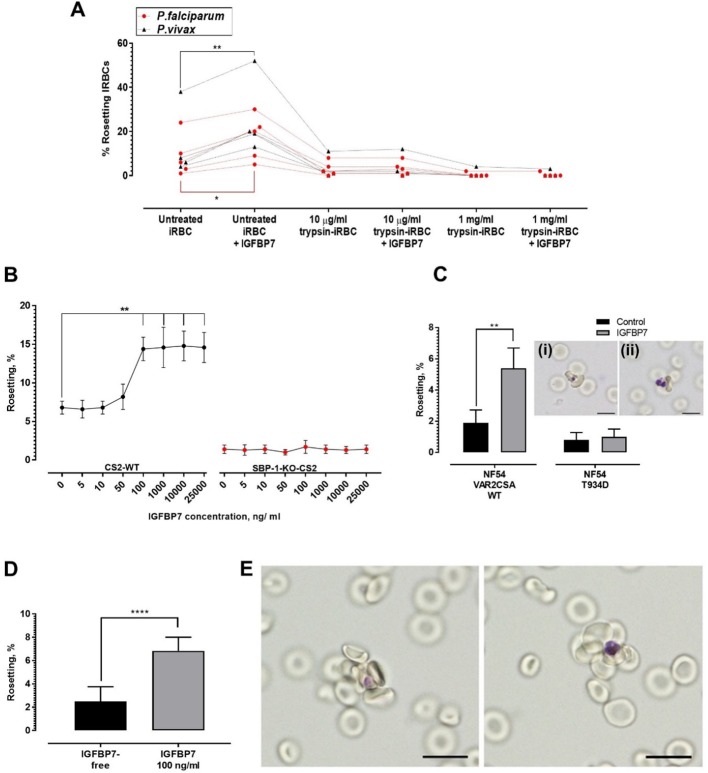
Deciphering rosetting ligands involved in IGFBP7-mediated rosetting.(A) IRBC-trypsin treatments on IGFBP7-mediated rosetting. Dotted lines demonstrate data collected from same isolates. IGFBP7 increased rosetting in the untreated settings (paired t-test Pf (n = 5): p=0.0171; Pv (n = 4): p=0.0023) but did not significantly alter rosetting in groups treated with 10 µg/ml trypsin (Pf: p=0.3739; Pv: p=0.3910) and 1 mg/ml trypsin (Pf: same values; Pv: p=0.3910). (B) Rosetting rates (mean and SD from quintuplicate experiment repeats shown) along rhIGFBP7 concentrations for PfCS2-WT and PfSBP1-KO-CS2. Significant CS2-WT rosette-stimulation was noted from rhIGFBP7 of 100 ng/ml (Friedman with Dunn’s test: p=0.0230). No significant changes noted for SBP1-KO-CS2 across the range of IGFBP7 concentrations studied (Friedman with Dunn’s test: p>0.9999). (C) Effect of IGFBP7 on rosetting rates of NF54_VAR2CSA_WT and NF54_T934D (mean and SD from quintuplicate experiment repeats shown). The Mann-Whitney test was conducted. For NF54_VAR2CSA_WT, IGFBP7 significantly increased the rosetting rates (p=0.0079). For NF54 VAR2CSAT934D, IGFBP7 did not cause any significant change to the rosetting rates of the parasite (p=0.7619). The rosettes formed by NF54_VAR2CSA_WT (i) and NF54_VAR2CSA_T934D (ii) are small. (D) Rosetting rates of the late ring forms (means and SD of nine replicates shown) under IGFBP7-free and IGFBP7-supplied conditions. The Mann-Whitney test was conducted. Rosetting rates were significantly higher in the IGFBP7-supplied group (p<0.0001). (E) Rosettes formed by the late ring stage (left) and late trophozoite stage (right) of P. falciparum. Scale bar: 10 µm.
Figure 5—source data 1.Raw data (rosetting rates, %) for the data set presented in the bar graph (Figure 5C).R = biological replicate (same parasite line, but different flasks of cultures using the same URBCs and culture media).

Figure 5—source data 2.Raw data (rosetting rates, %) for the data set presented in the bar graph (Figure 5D).R = biological replicate (same lab-adapted parasite, but conducted on three cycles of ring stages from three different flasks of cultures using the same batch of URBCs and culture media). F = flask, C = cycle.